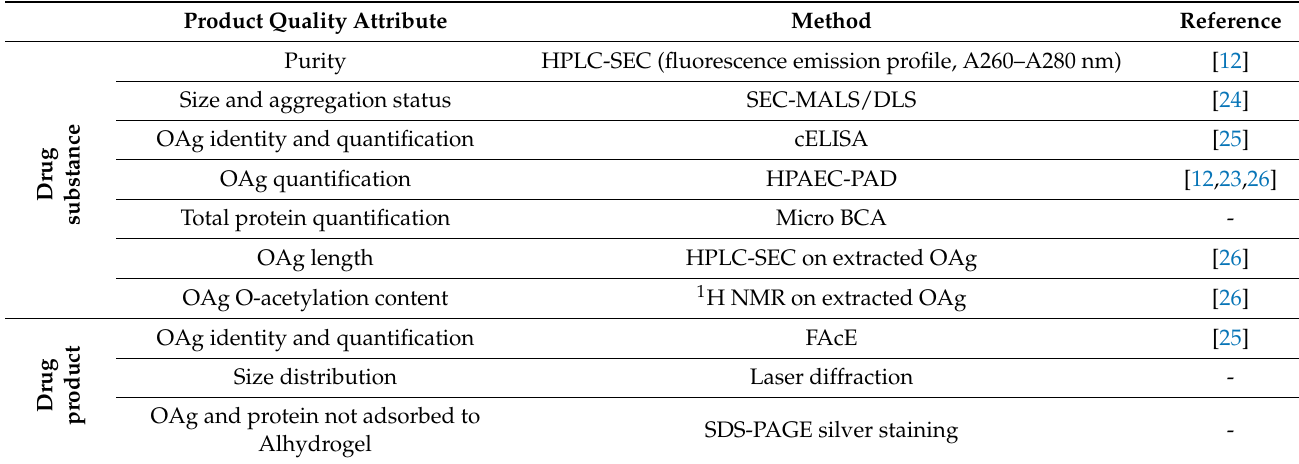
Table 1. Panel of analytical methods used for the characterization of GMMA drug substances and drug products, thus formulated with